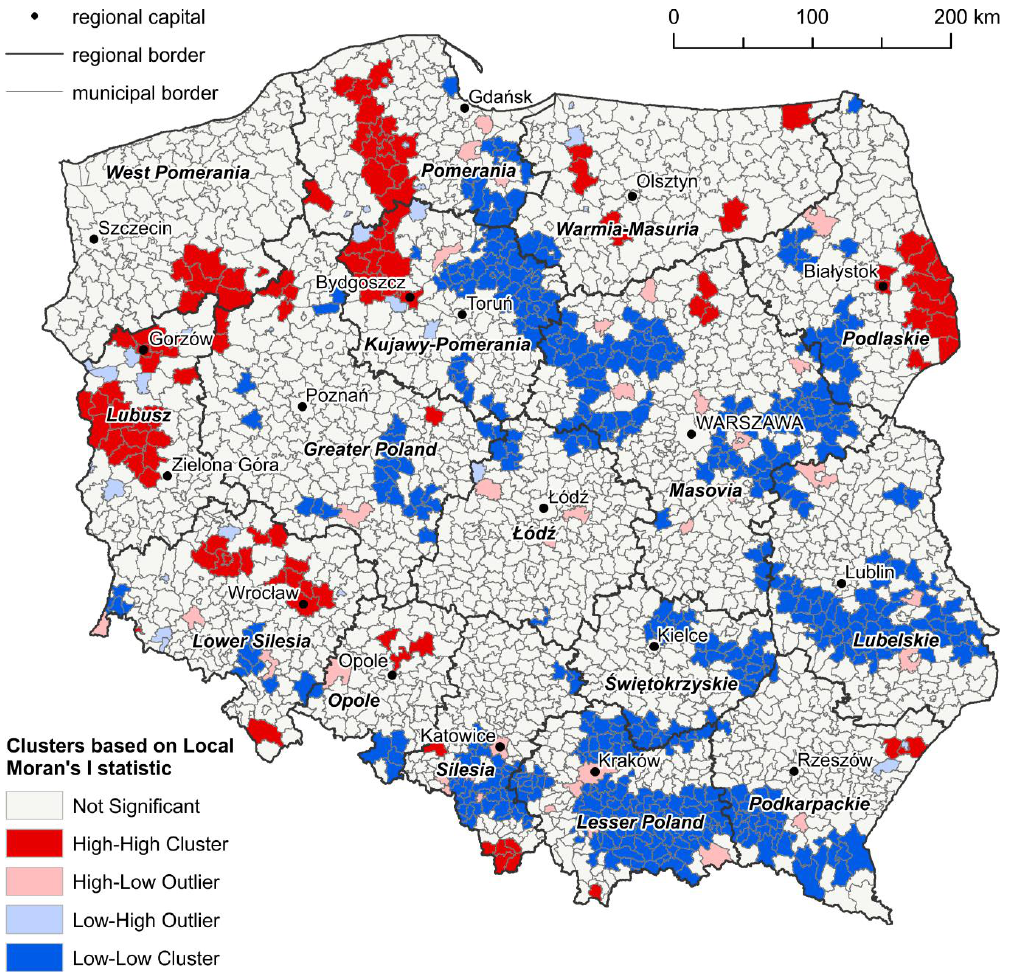
Figure 1. Hot spots and cold spots of spatial distribution of land cover changes in Poland, in the years 2012–2018. years